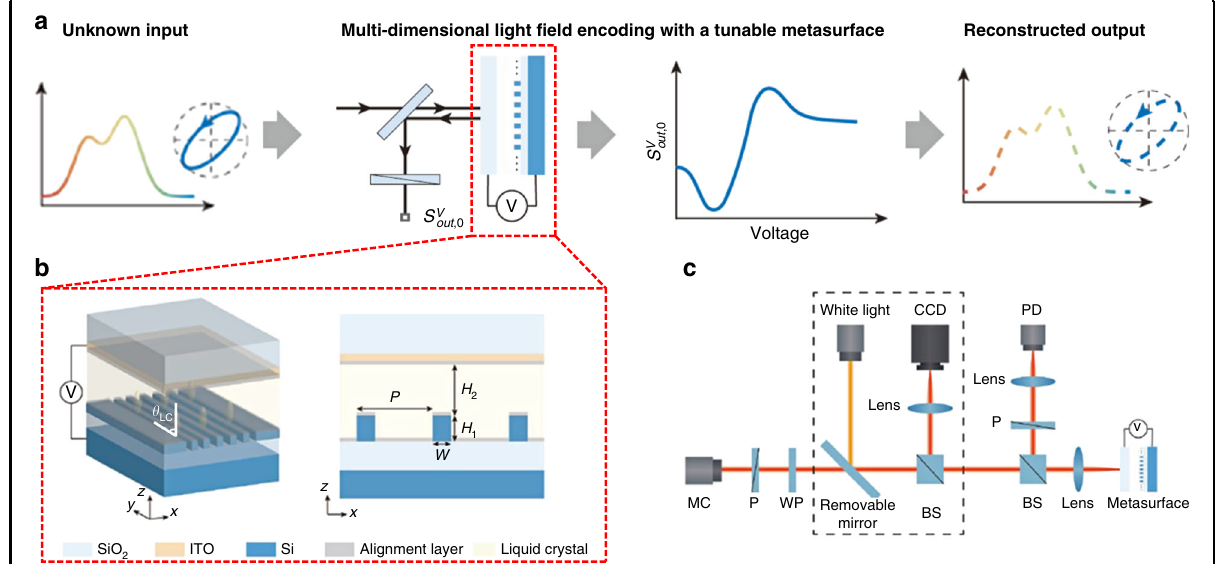
Fig. 1 Computational spectropolarimetry with a tunable liquid crystal metasurface. a Illustration of computational spectropolarimeter ’ s working principle. b Schematic of electrically tunable liquid crystal-embedded silicon metasurface. c Experimental setup for the spectropolarimetric